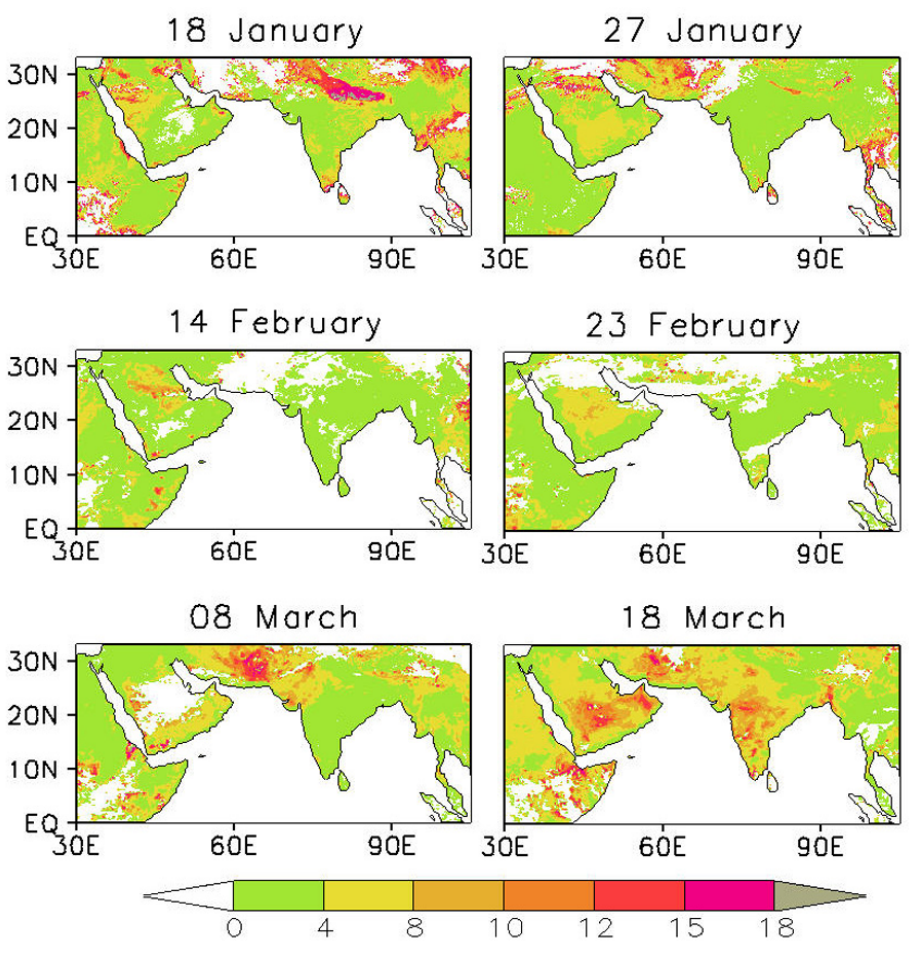
Fig. 13. Typical examples of regional distribution of IDDI (K) during January, February and March.